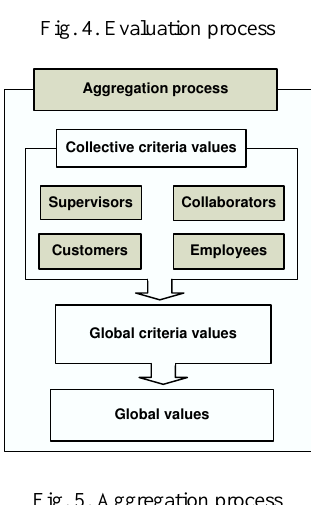
Fig. 5. Aggregation